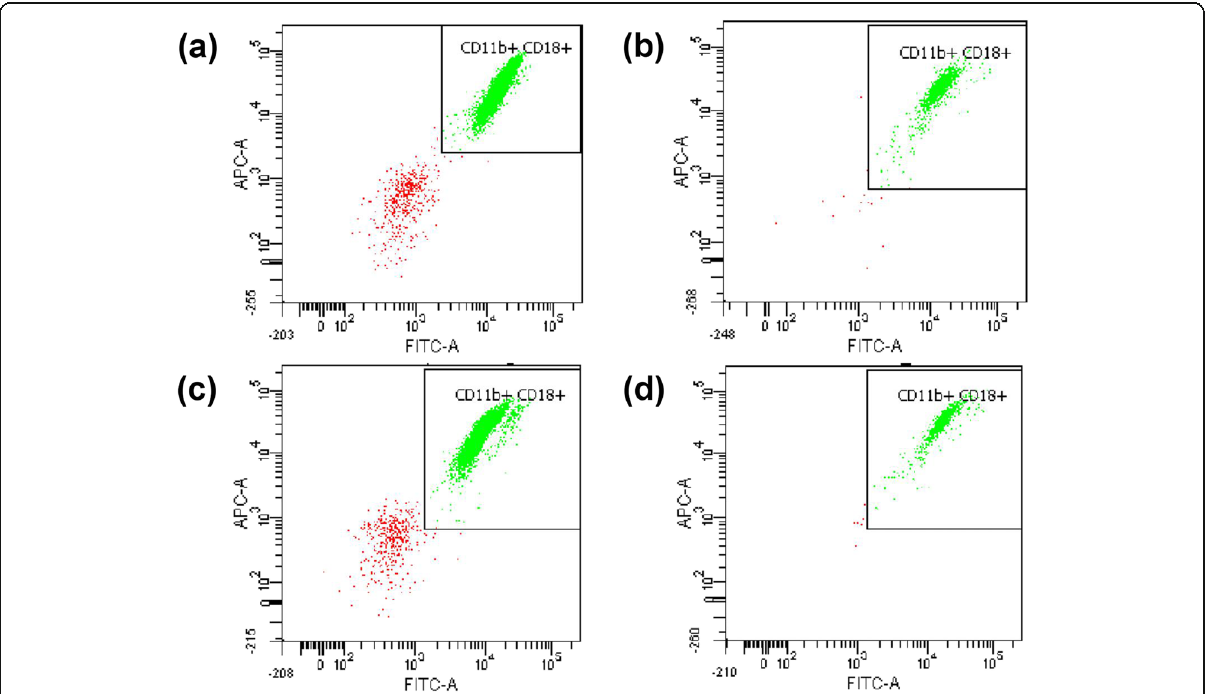
Fig. 4 CD11b/CD18 expression activity by neutrophils treated with test samples i.e., ( a ) positive control, ( b ) Z. zerumbet extract (50 μ g/mL), ( c )